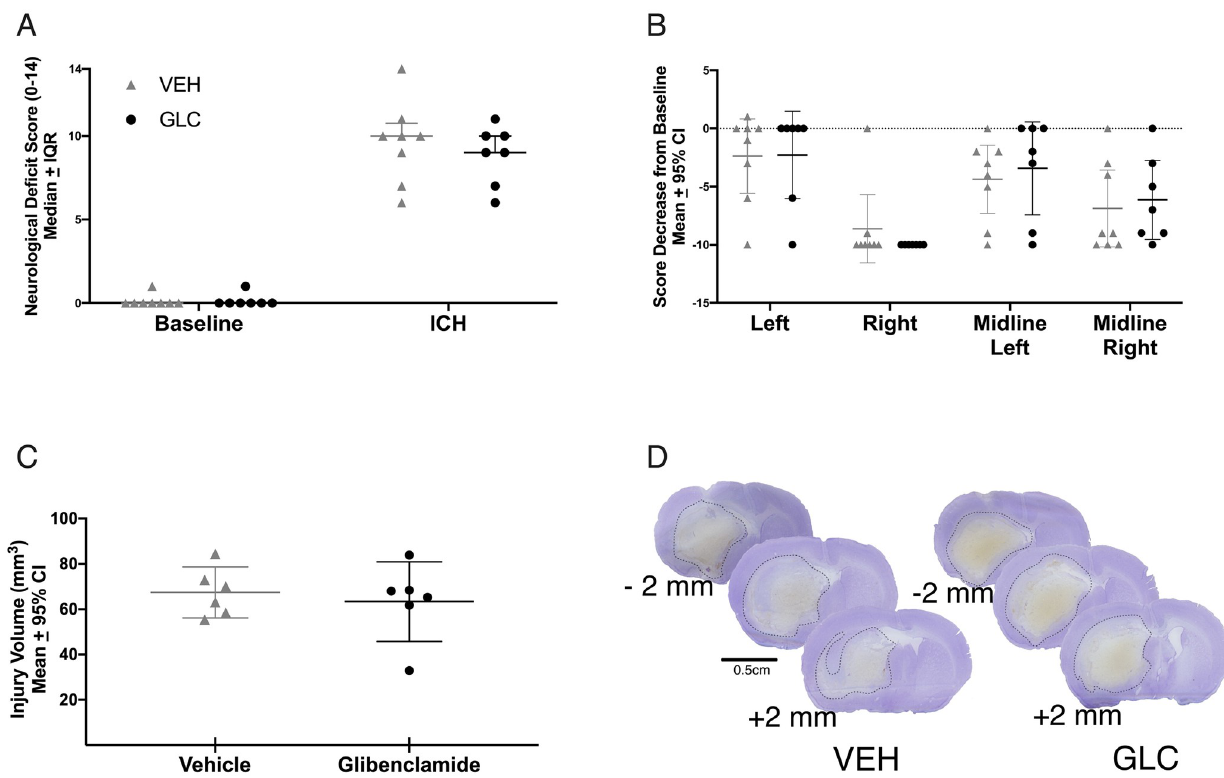
Fig 6. Experiment 3 injury volume and behaviour. No benefit of glibenclamide was found on either NDS (A, p = 0.5970), or forelimb placing of any paw (B, p � 0.4432). No difference was found in injury volume ± 4 mm around the maximum hematoma (C, p = 0.1280) between groups, reinforcing the results of experiment 1 that glibenclamide does not affect bleeding. Representative cresyl violet stained sections of -2 mm (anterior) to the maximum hematoma area, the maximum hematoma area, and +2 mm (posterior) to the maximum hematoma area are shown (D).